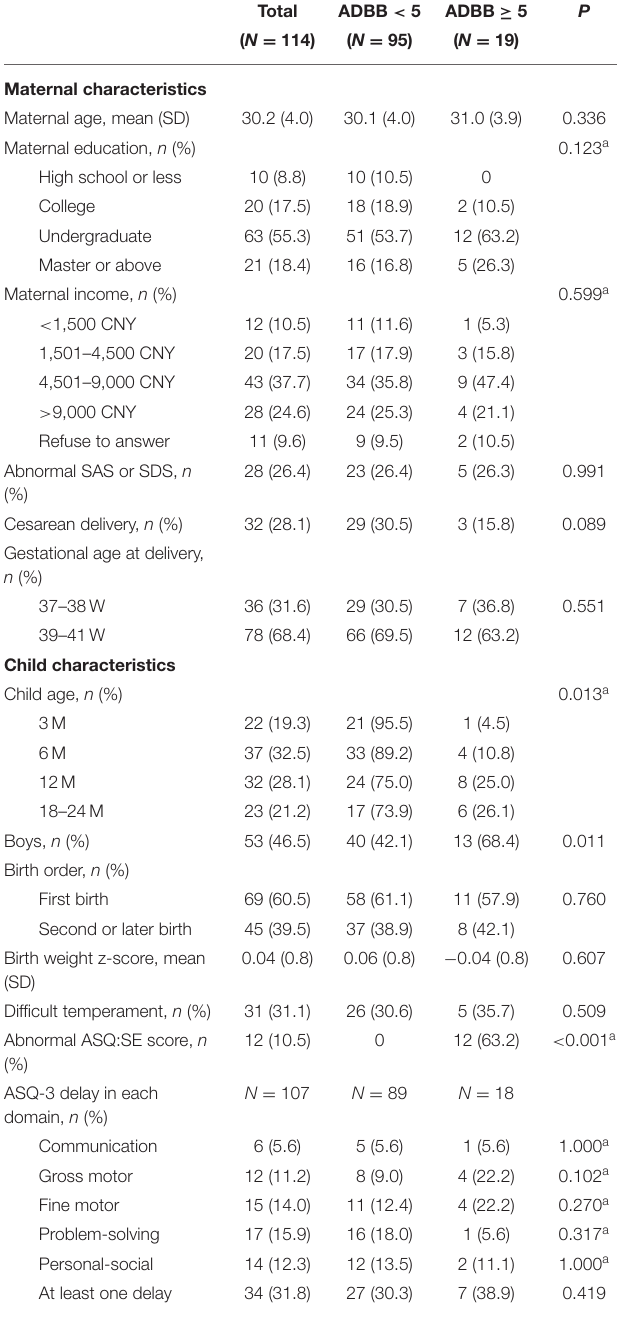
TABLE 1 | Maternal and child characteristics by the ADBB